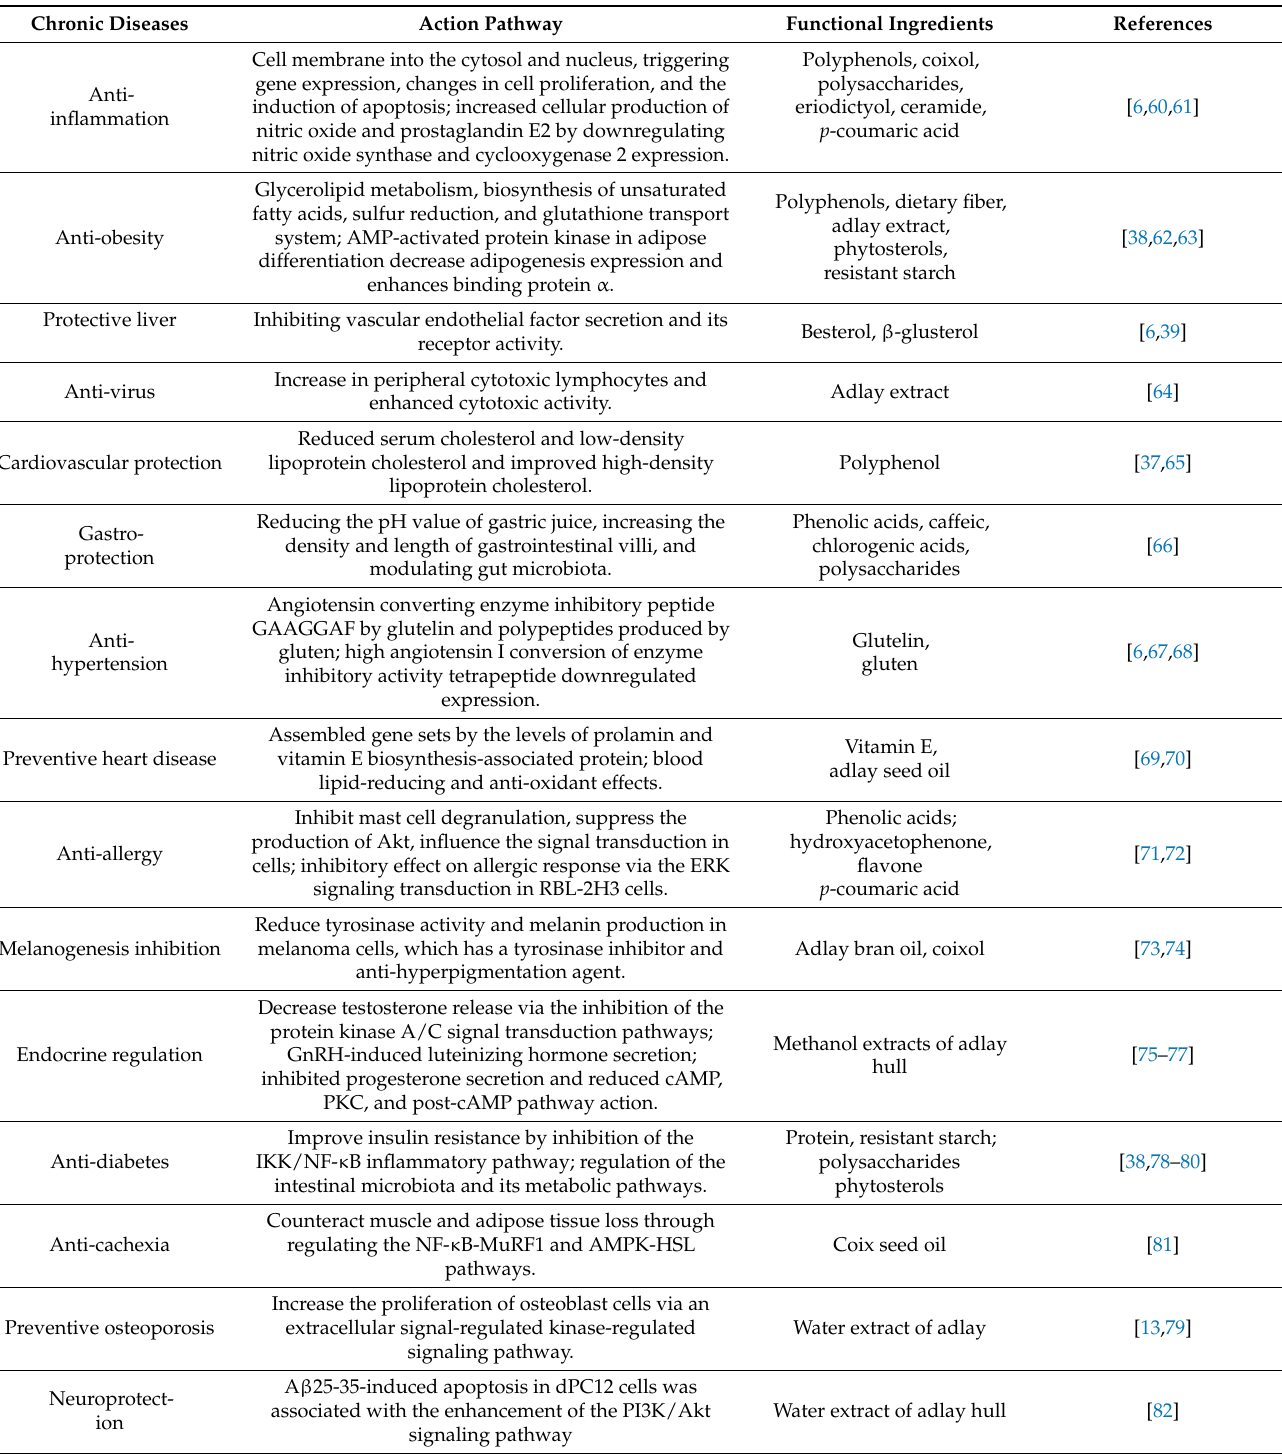
Table 4. Action pathway and functional ingredients of adlay in preventing chronic diseases other than